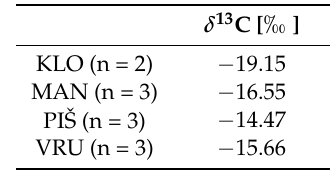
Table 4. Average δ 13 C values for H. trunculus (n = number of samples collected).